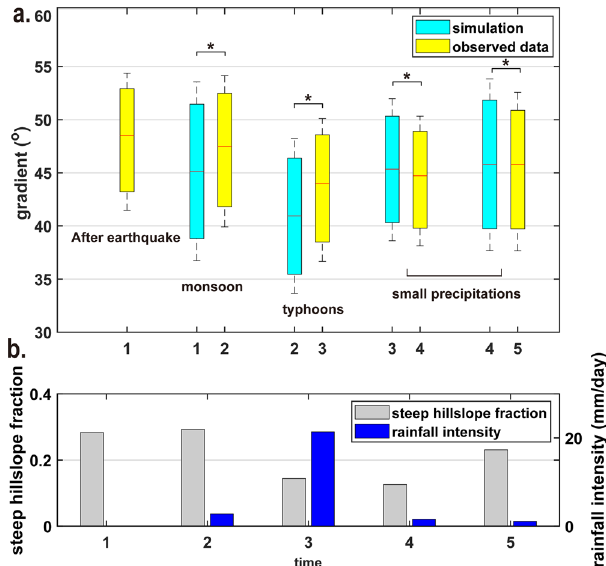
Fig. 4 Distribution of hillslope gradients. a Compiled observed (yellow) and simulated (cyan) distribution of hillslope gradients. The upper limit of the box means 75% of percentile, the lower limit of the box means 25% of percentile. Signi fi cant differences ( p < 0.01) between the initially observed data and simulations using the Kolmogorov – Smirnov test are indicated by *. b Gray bars denote the fraction of steep gradients (> 55 o ) at small drainage areas (<0.5 m 2 ). The blue bar denotes rainfall